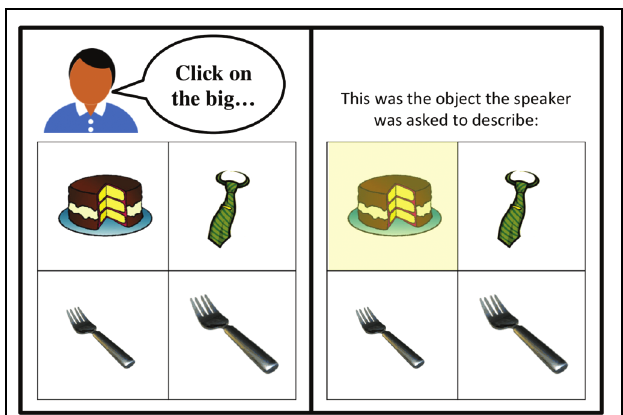
FIGURE 8 | An example of a trial (audio instructions are shown here in speech bubbles) with the modifying speaker (left) in the Exposure Phase in Experiment 4. Participants clicked on the image in the grid to respond. After each trial participants were shown which of the four images the speaker was asked to describe (right)